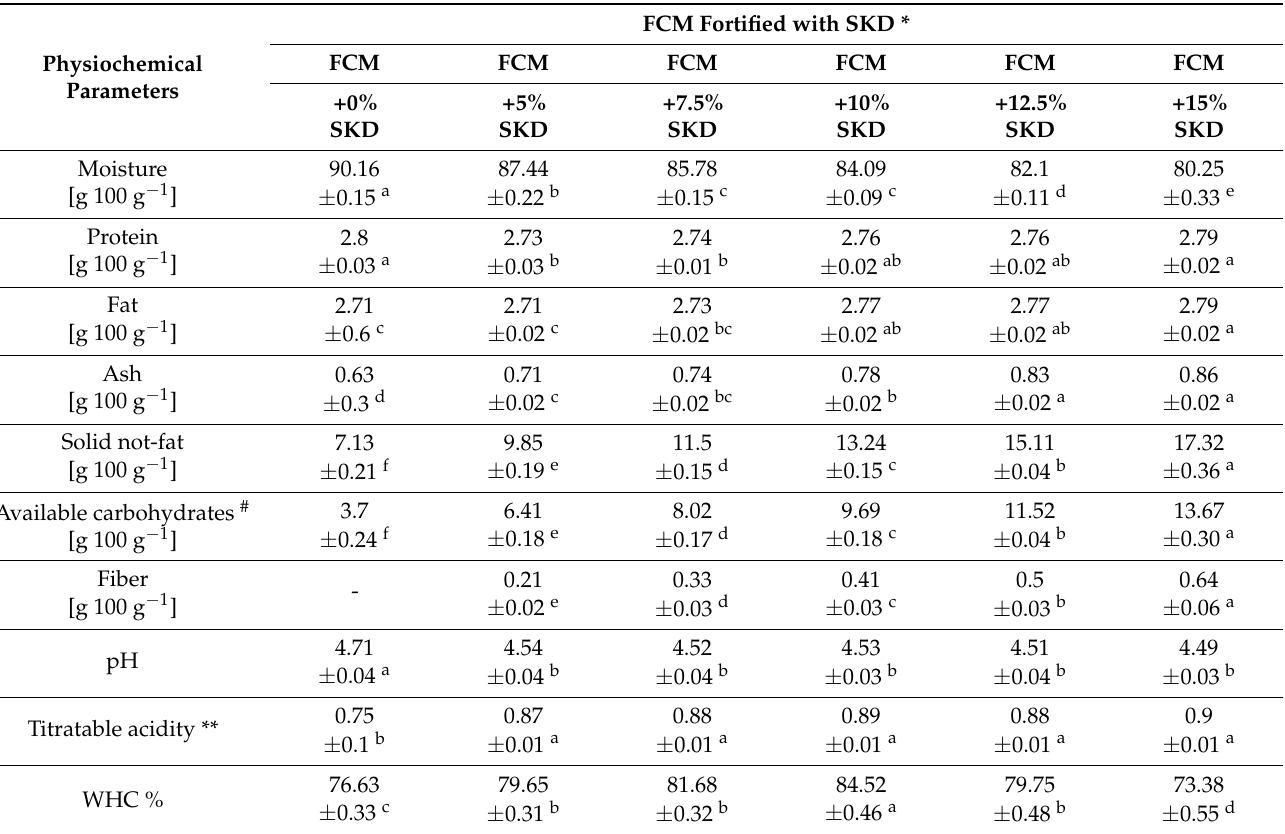
Table 2. Chemical composition and physicochemical properties of fermented camels’ milk (FCM)